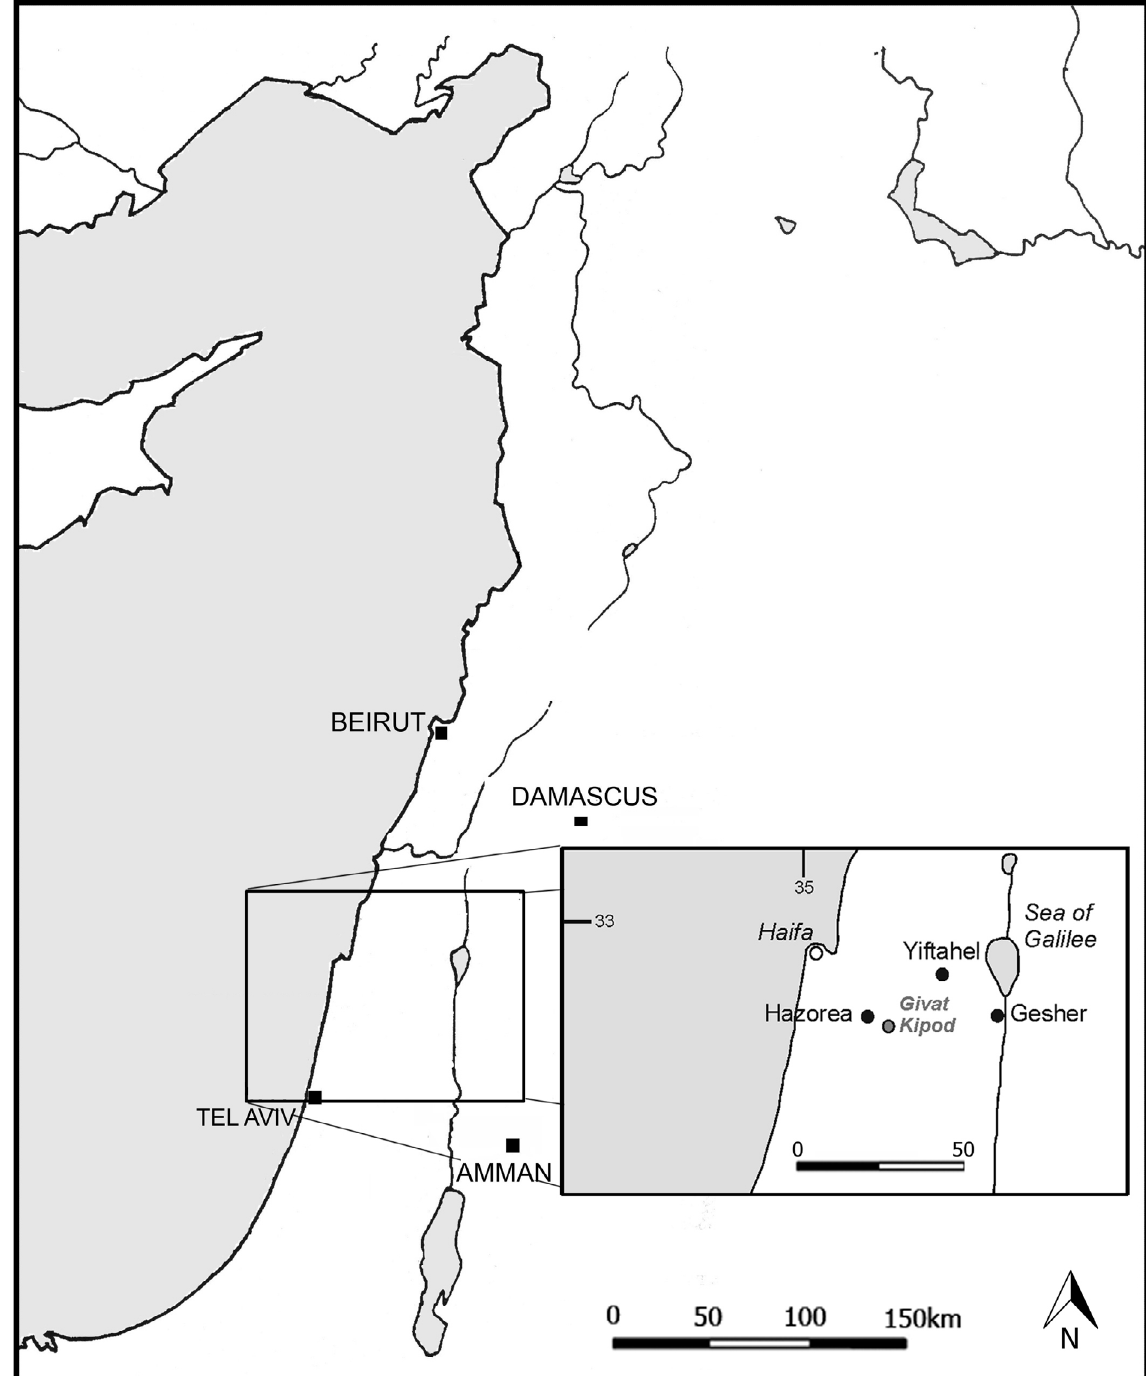
Figure 1. A map showing the location of Giv’at